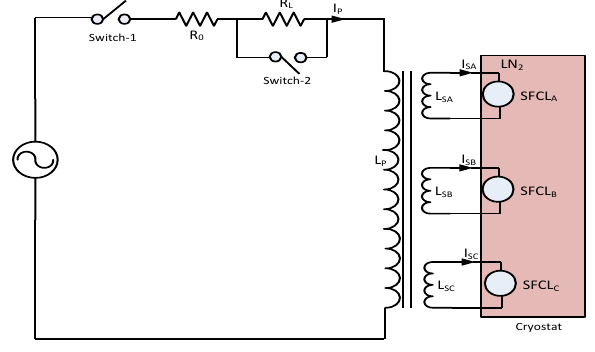
Figure 6. Structure of hybrid SFCL.